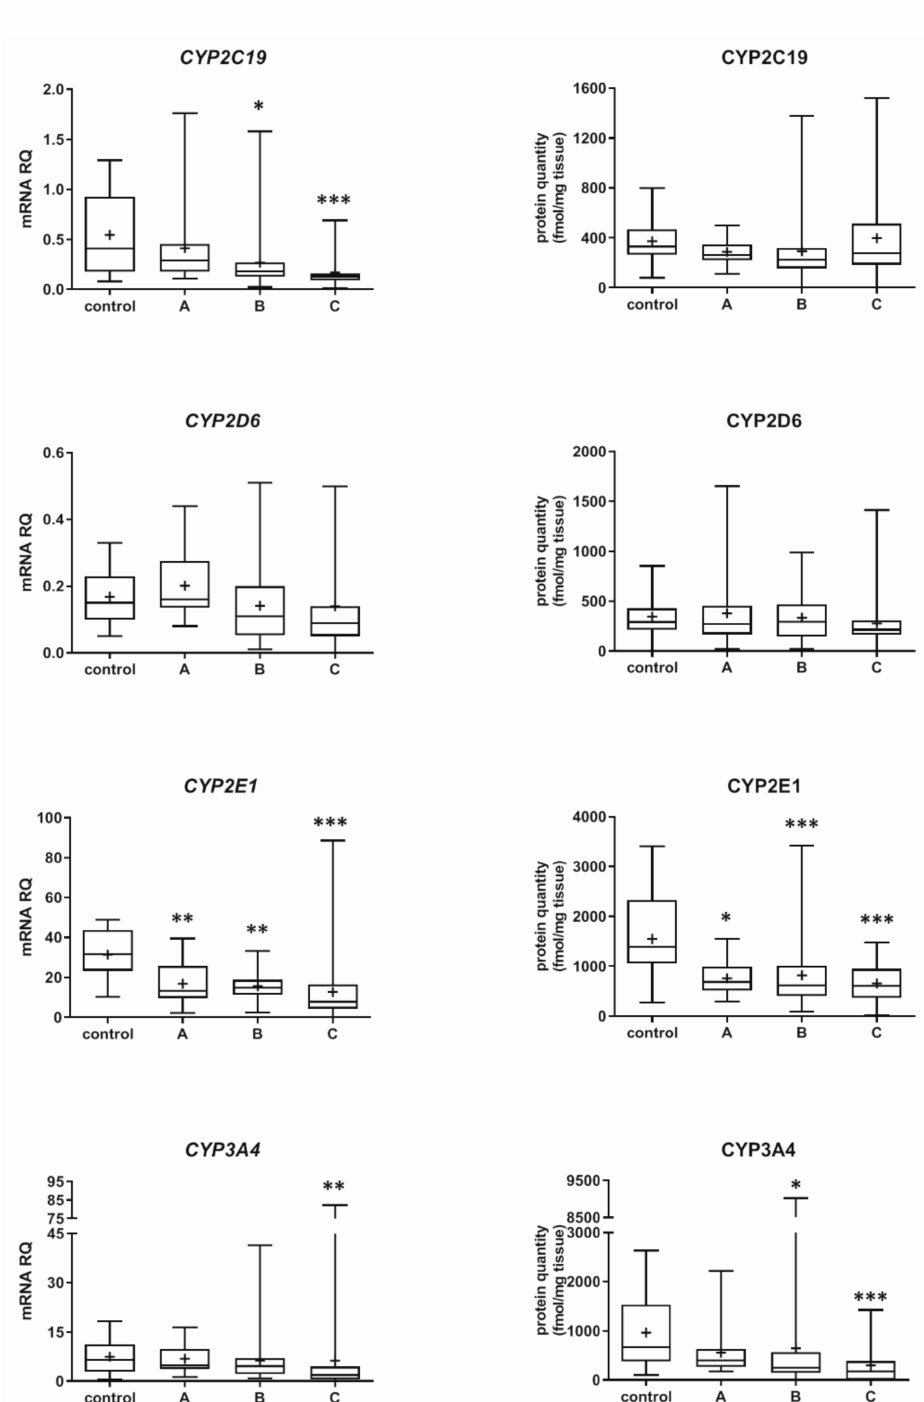
Figure 1. (also see page up) Gene expression ( left ) and protein abundance ( right ) of CYPs in hepatic tissues stratified according to the Child–Pugh score into stages: A ( n = 18), B ( n = 31) and C ( n = 28). The data are represented as box-plots of the median (horizontal line), 75th (top of box), and 25th (bottom of box) quartiles, the smallest and largest values (whiskers) and mean (+) are shown. mRNA levels of the analyzed genes were expressed as relative amounts to the mean of five housekeeping genes (GAPDH, HMBS, PPIA, RPLP0, RPS9). Statistically significant differences: * p < 0.05, ** p < 0.01, *** p < 0.001 (Kruskal–Wallis test post hoc Dunn’s test with Bonferroni correction) in comparison to the